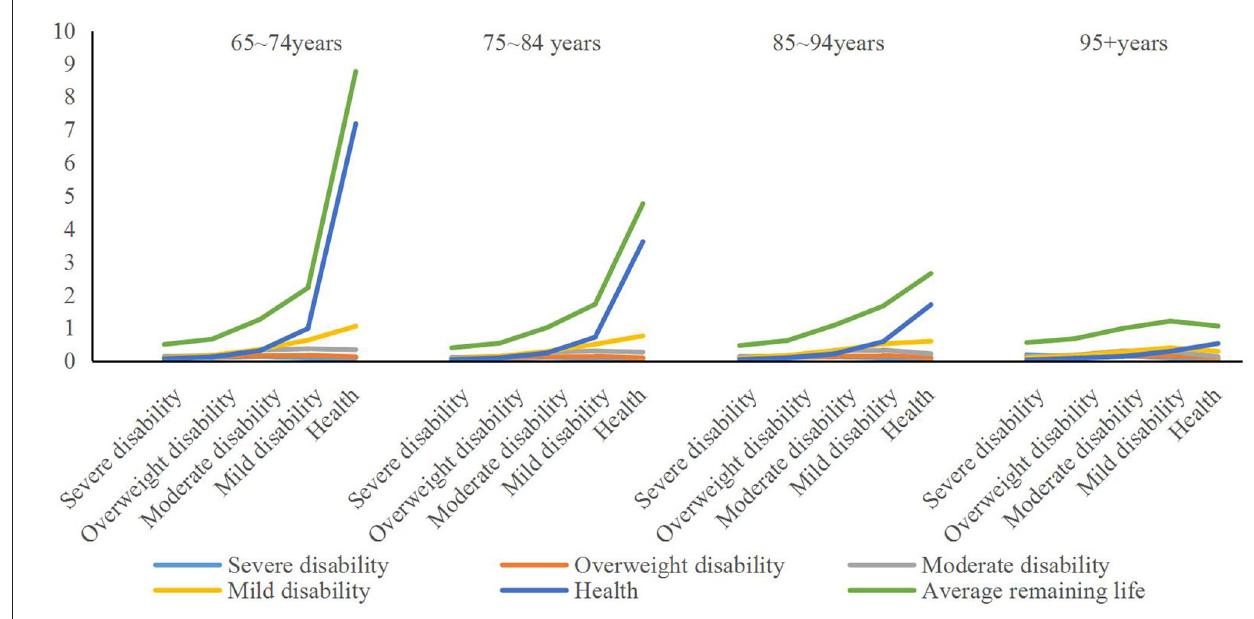
FIGURE 3 | Comparison of the state duration and expected remaining life trend under different age samples. Unit is year.